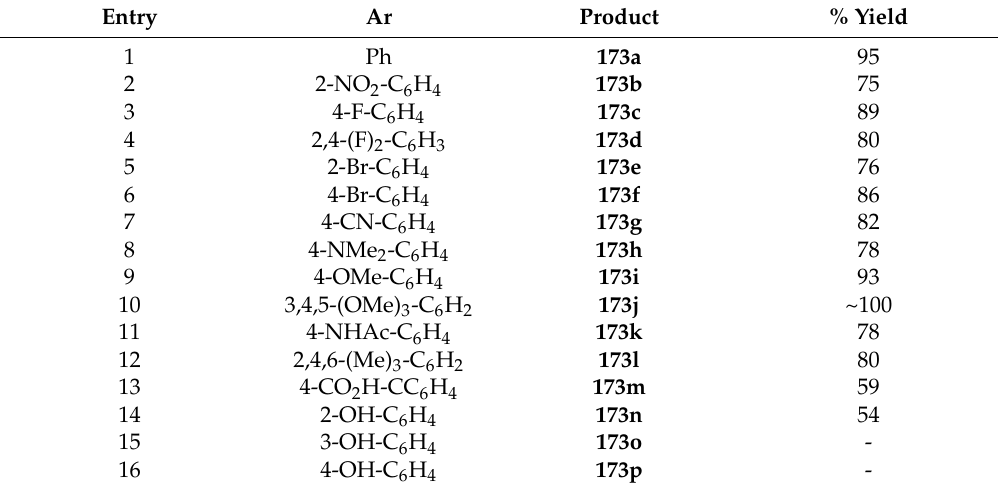
Table 24. Cycloaddition of azomethine ylide 172 , formed from silylamine reagent 178 , with heteroaromatic aldehydes 2 (Scheme 45).